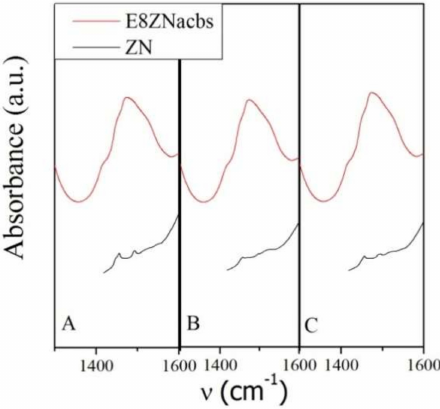
Figure 9. Pyridine adsorption: A = 150 ◦ C, B = 250 ◦ C, C = 350 ◦